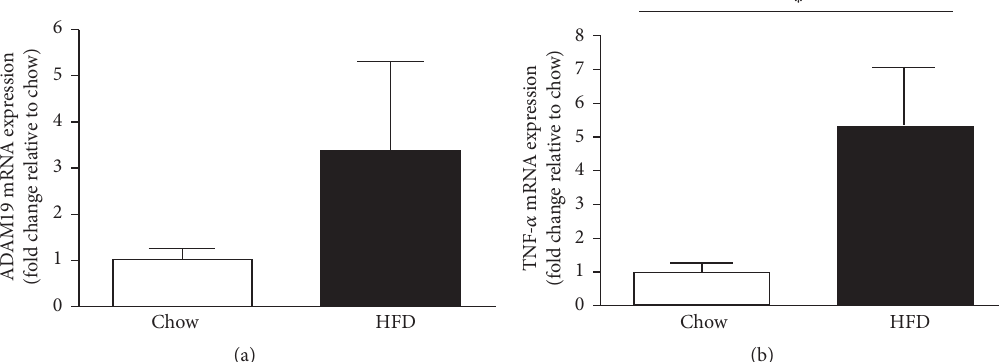
Figure 3: Elevated Adam19 (a) and Tnf- 𝛼 (b) mRNA levels in gonadal white adipose tissue of mice on a high fat diet for 16 weeks. ∗ 𝑝 < 0.05 ; 𝑛 = 7 -8 mice/group.